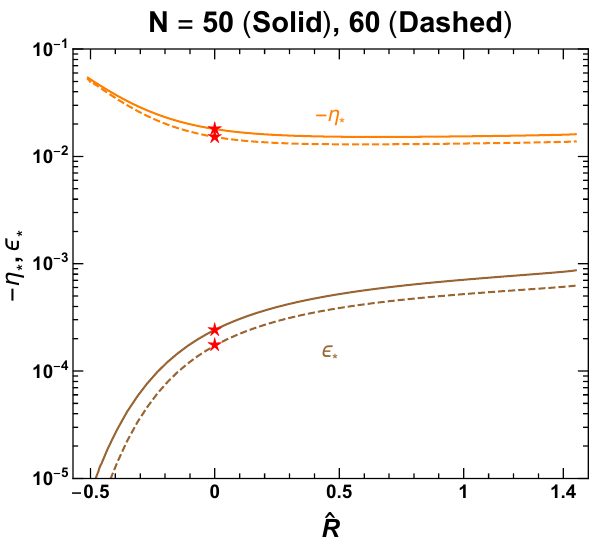
Figure 1 . Slow-roll parameters as a function of ^ R (cid:17) (cid:24) 1 = ( (cid:24) 2 + (cid:24) H (cid:28) 2 ) 1 = 2 . We have chosen the number of efoldings to N = 50 ; 60 in solid and dashed lines, respectively. Star points correspond to the case with ^ R = 0.